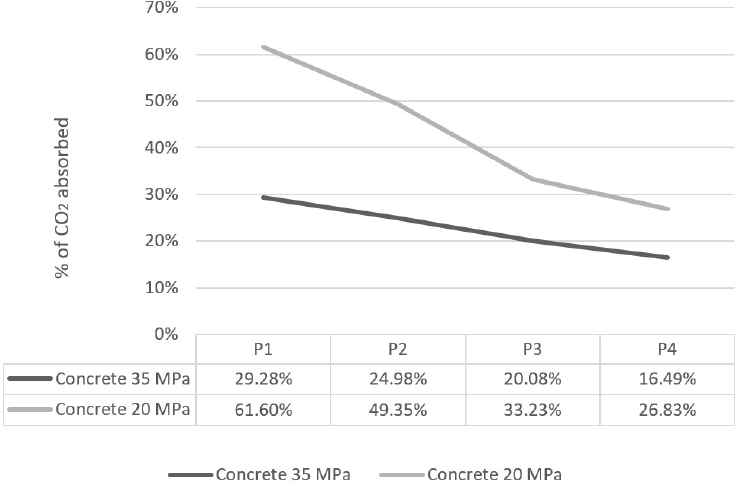
Figure 10. CO 2 capture during the useful life of columns designed with 20 and 35 MPa